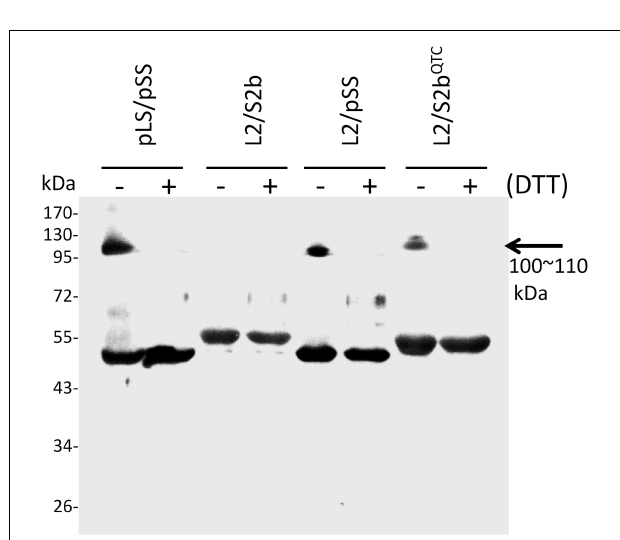
FIGURE 3 | Immunoblot analysis of dimer formation of AGPase variants. 0.2 µ g of partially purified enzymes (pLS/pSS, L2/S2b, L2/pSS, and L2/S2b QTC ) were boiled for 5 min in a SDS sample buffer containing 62.5 mM Tris-HCl (pH 6.8), 2% w/w SDS, 7.5% v/v glycerol in the absence (–) or presence (+) of 10 mM DTT. The samples were resolved by SDS-PAGE and analyzed by immunoblotting using anti-potato tuber AGPase SS. The arrow indicates dimers of potato AGPase SS (pSS) or rice AGPase S2b (S2b QTC ).